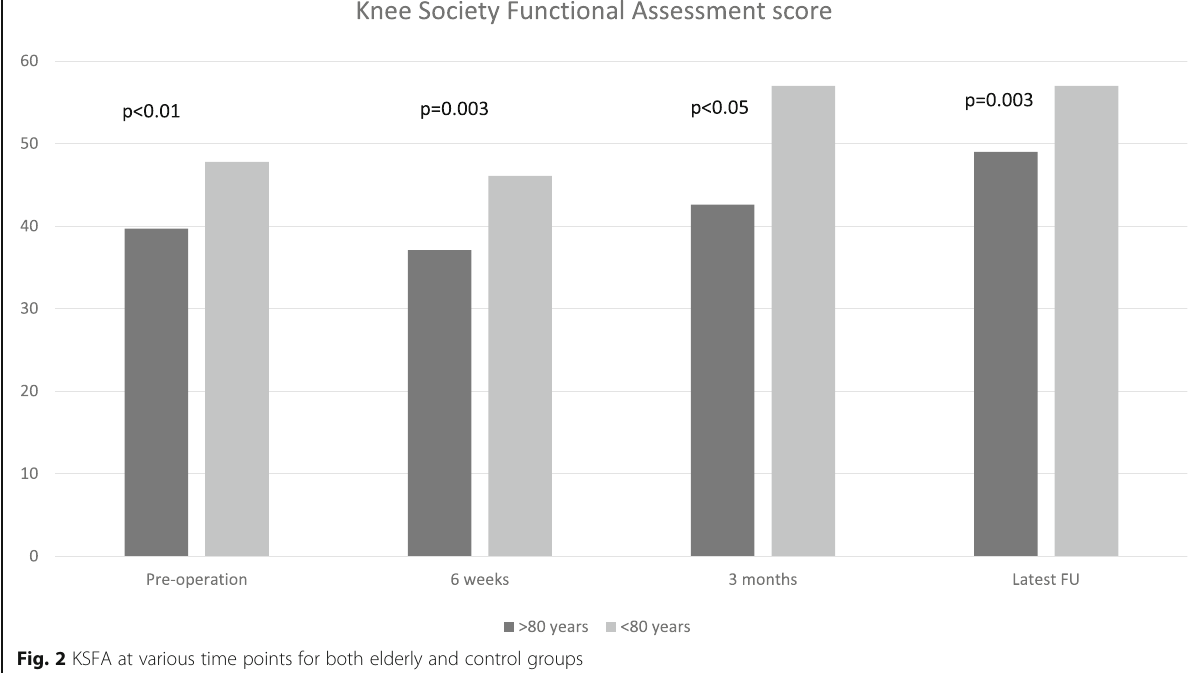
Table 3 details the baseline characteristics of elderly patients undergoing traditional rehabilitation and those receiving a fast-track regimen. Elderly patients undergo- ing rehabilitation via a fast-track regimen had statisti- cally significantly shorter length of hospital stay than